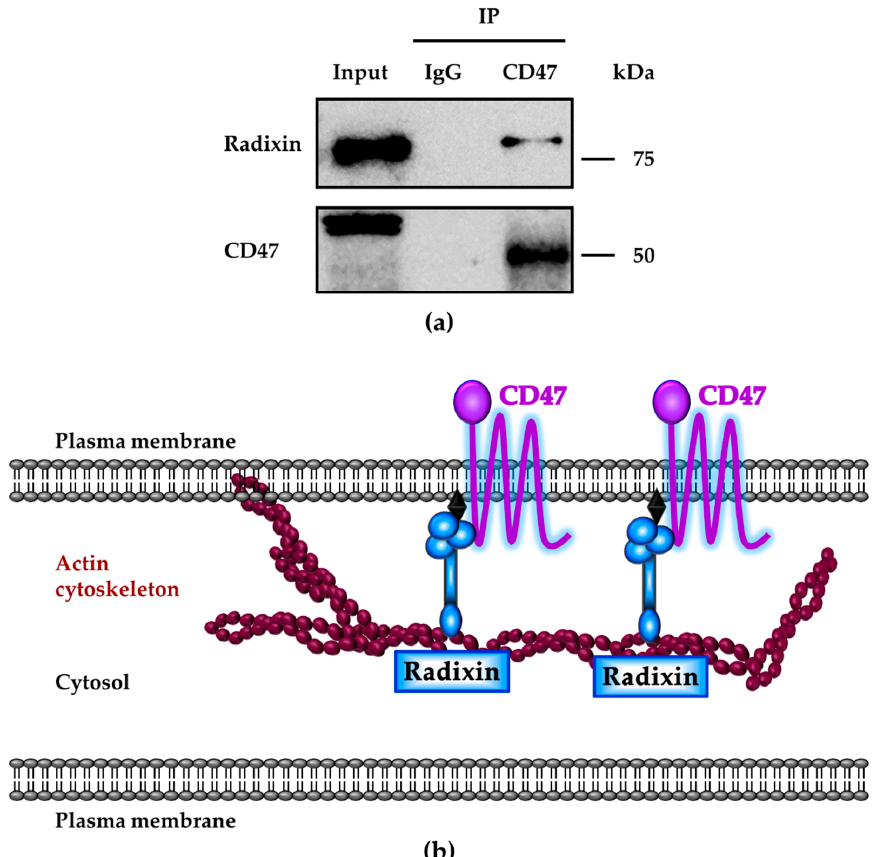
Figure 5. Molecular interaction between CD47 and radixin in KP-2 cells. ( a ) Representative im- munoblots of CD47 and radixin in whole-cell lysates (input) and those co-immunoprecipitated with an anti-CD47 antibody (Ab) or its isotype-matched control IgG Ab. IP: Immunoprecipitation, kDa: Molecular weights. ( b ) A schematic model illustrating the molecular interaction between CD47 and radixin in KP-2 cells.